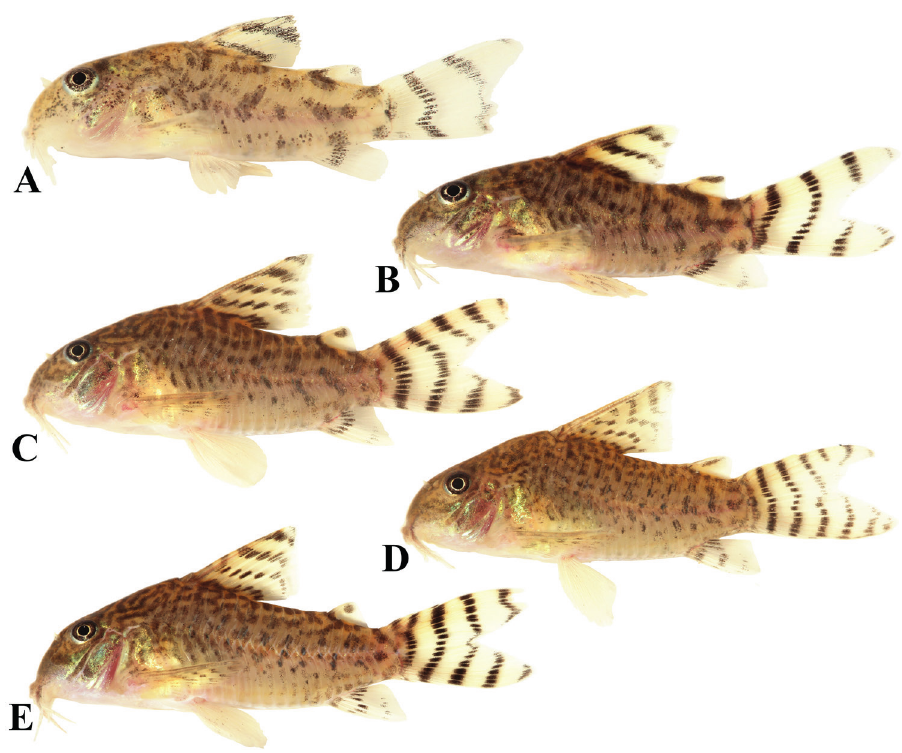
FIGURE 3 | Paratypes of Corydoras thanatos photographed alive, showing general color pattern and morphology in lateral view